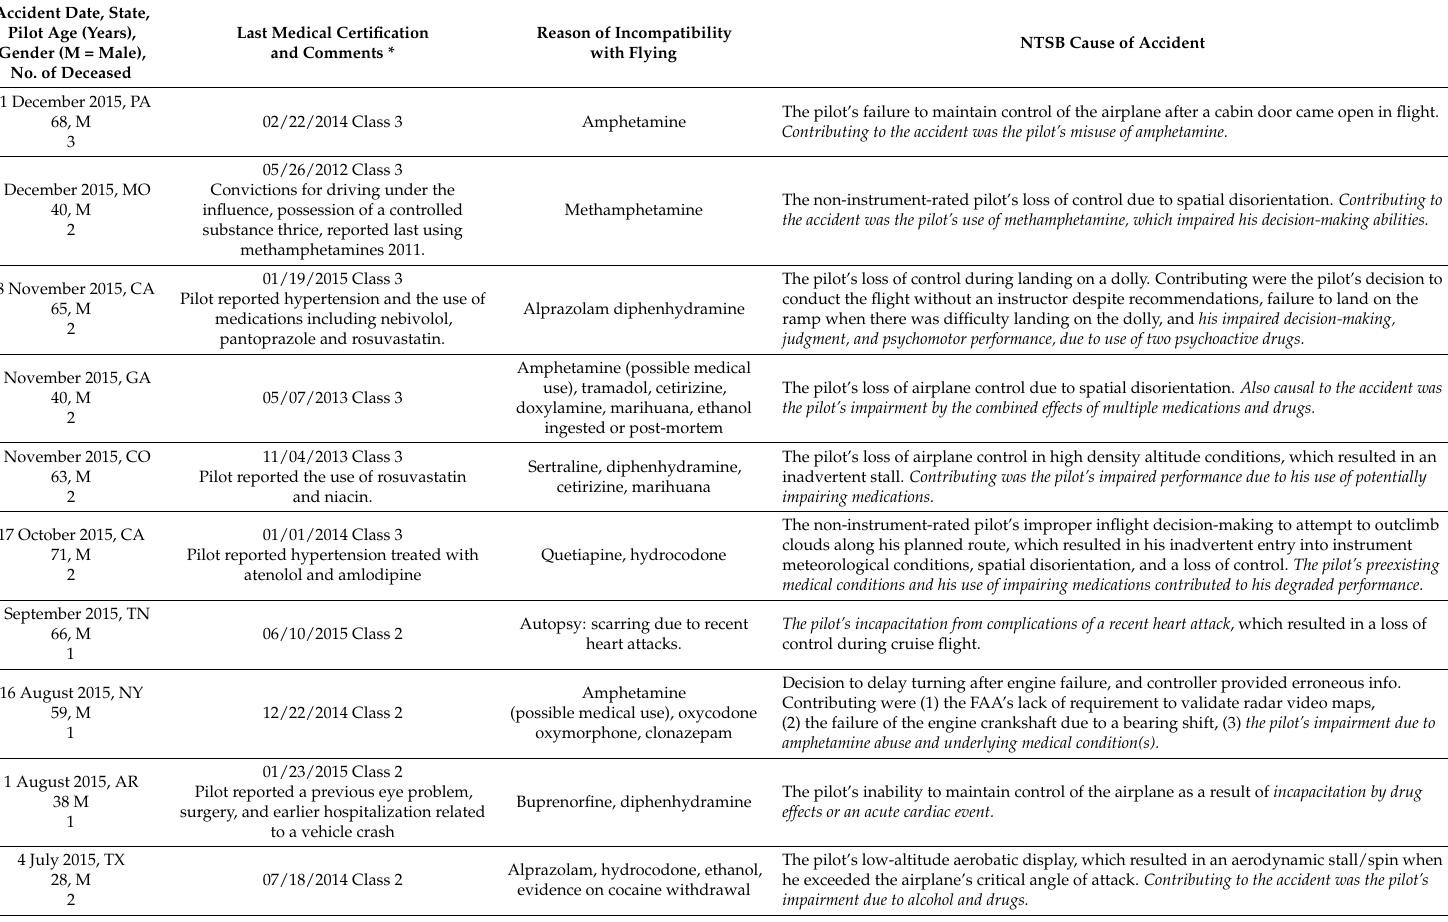
Table 2. Fatal aviation accidents where National Transportation Safety Board (NTSB) cause or contributing cause of accident is related to pilot health issues not reported to an aeromedical examiner in 2015